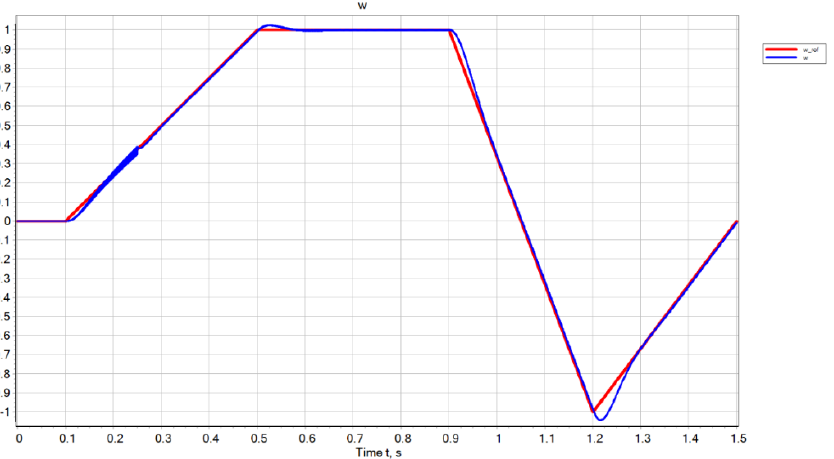
Figure 7. The specified angular velocity and angular velocity of the motor at a moment of inertia of the load 2.1 kg ∙ m 2 .